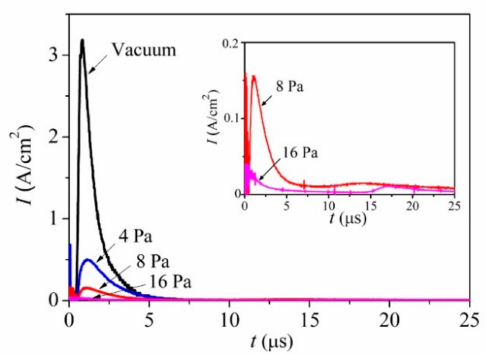
Figure 2. Pulsed ion signals that were detected by an ion probe during the pulsed laser ablation of the MoS 2 target, both in a vacuum and at di ff erent pressures of Ar bu ff er